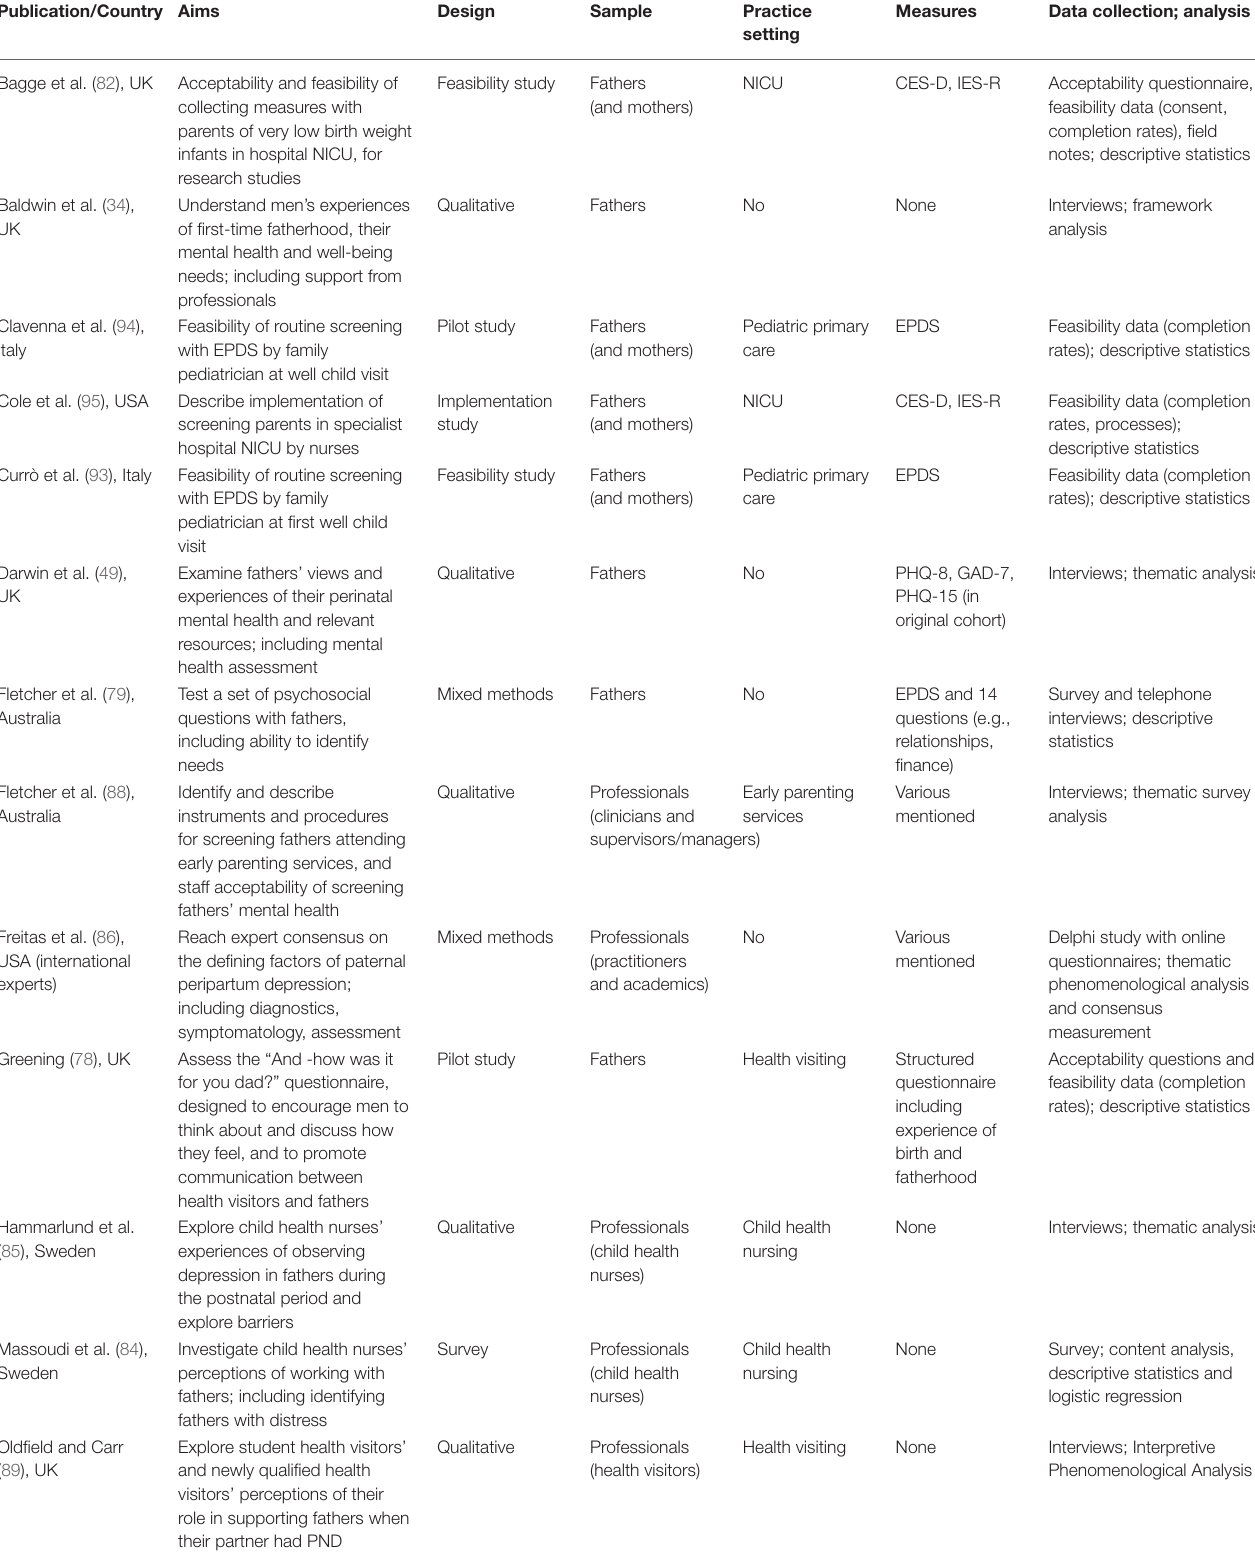
TABLE 2 | Summary of acceptability studies ( n =